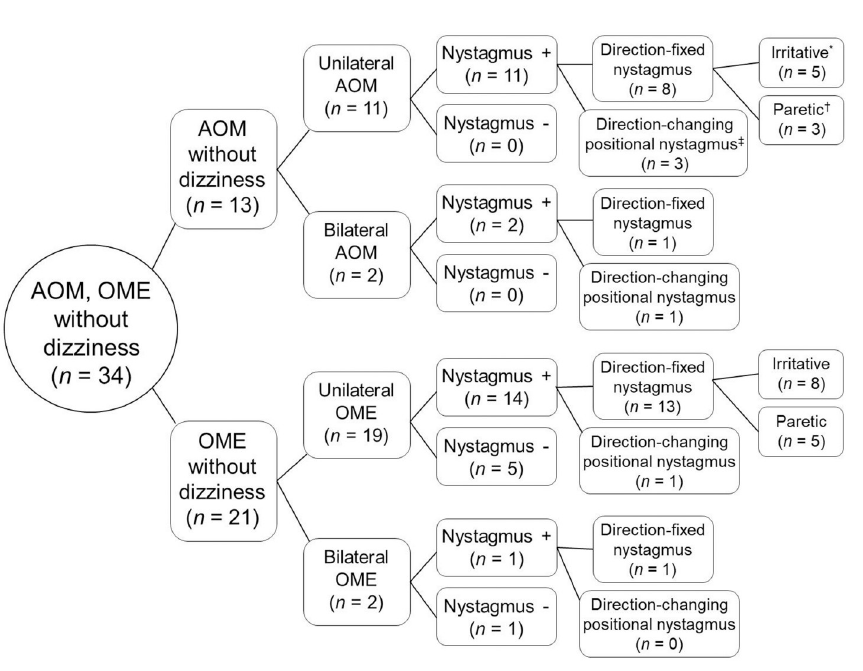
In 4 patients with bilateral effusions, 2 patients showed bilateral CHL, and 2 patients showed bilateral MHL. Nystagmus was observed in 21 of 27 patients with CHL, and 7 of 7 patients with MHL. The incidence of the presence of nystagmus was not significantly different between the patients with CHL and MHL ( p = 0.306, Fisher’s exact test). Out of 11 unilateral AOM patients, 8 exhibited direction-fixed nystagmus, which was irrita- tive type in 5 patients and paretic type in 3 patients. Irritative-type direction-fixed nystagmus was indicated when the observed nystagmus beats toward the lesioned ear, and paretic-type direction-fixed nystagmus was indicated when the direction of nystagmus was toward the